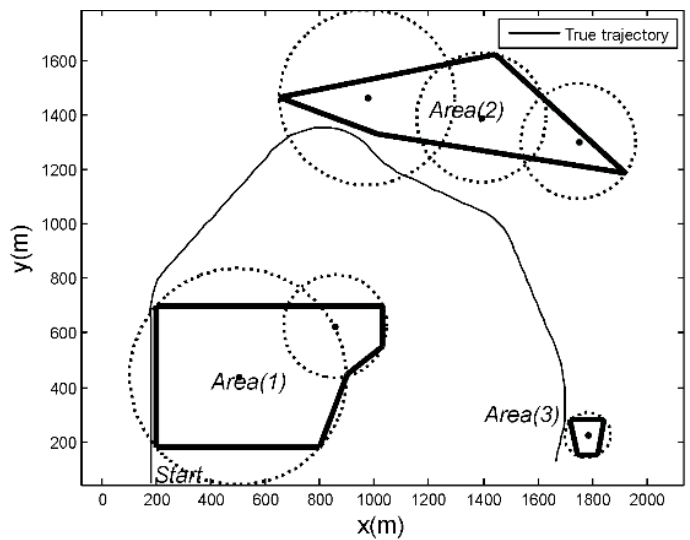
10 of 14 Table 2. Motion models and durations of the target’s trajectory.